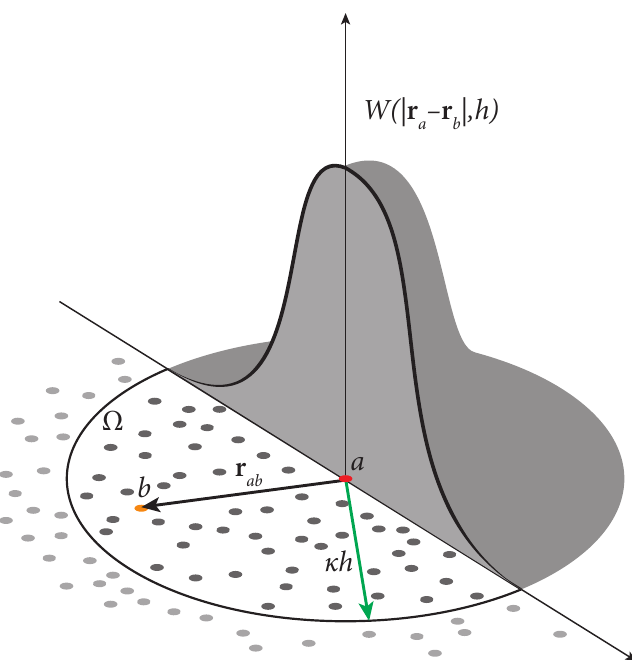
Figure 2. Smoothing kernel